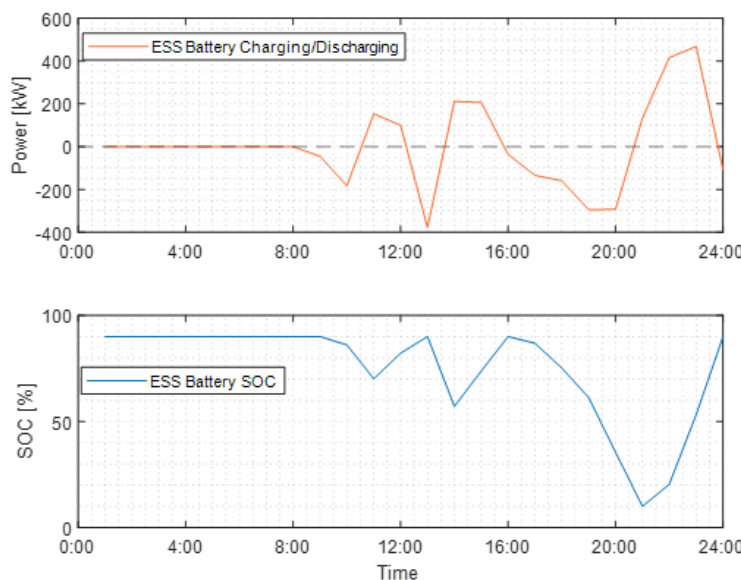
Figure 12. ESS operation at XFC8 on a summer ’s day.